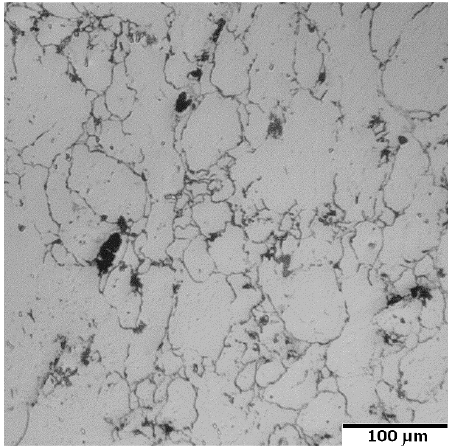
Figure 9. Typical microstructure of poorly sintered compacts made of Alumix 431D powder containing 1.5 mass% of Acrawax C sintered at a nitrogen linear flow of 6 cm/min.